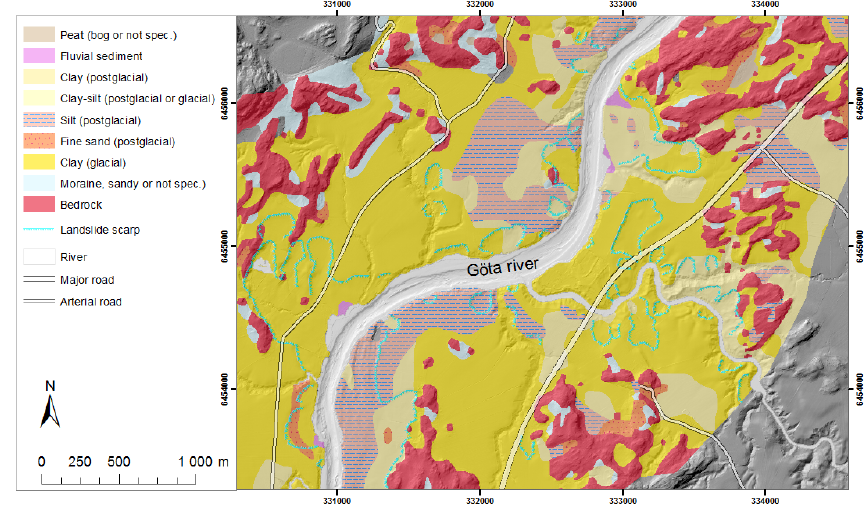
Figure 1. Landslide scarp map and Quaternary deposit map at 1 : 50000 for a subregion of the Göta Älv valley.